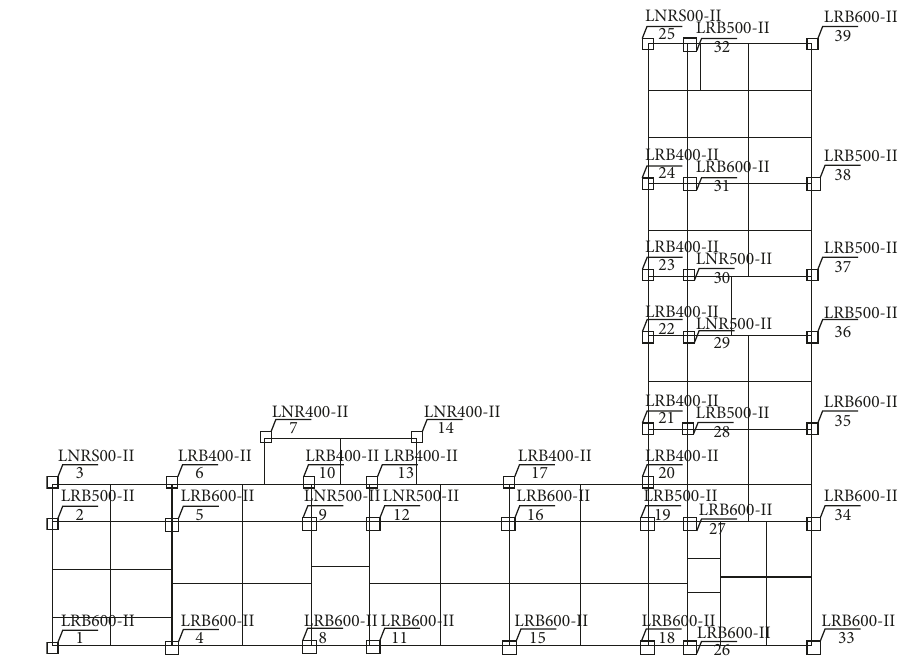
Figure 37: Arrangement of bearing design. Table 6: Eccentricity of seismic isolation